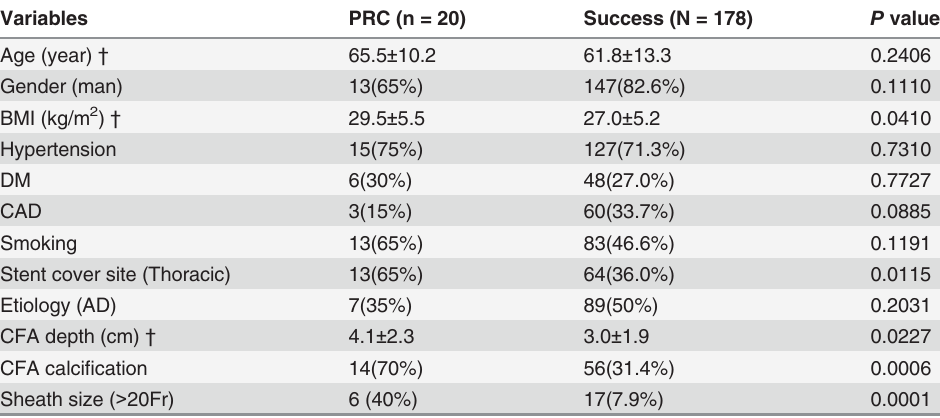
Table 3. Factors associated with